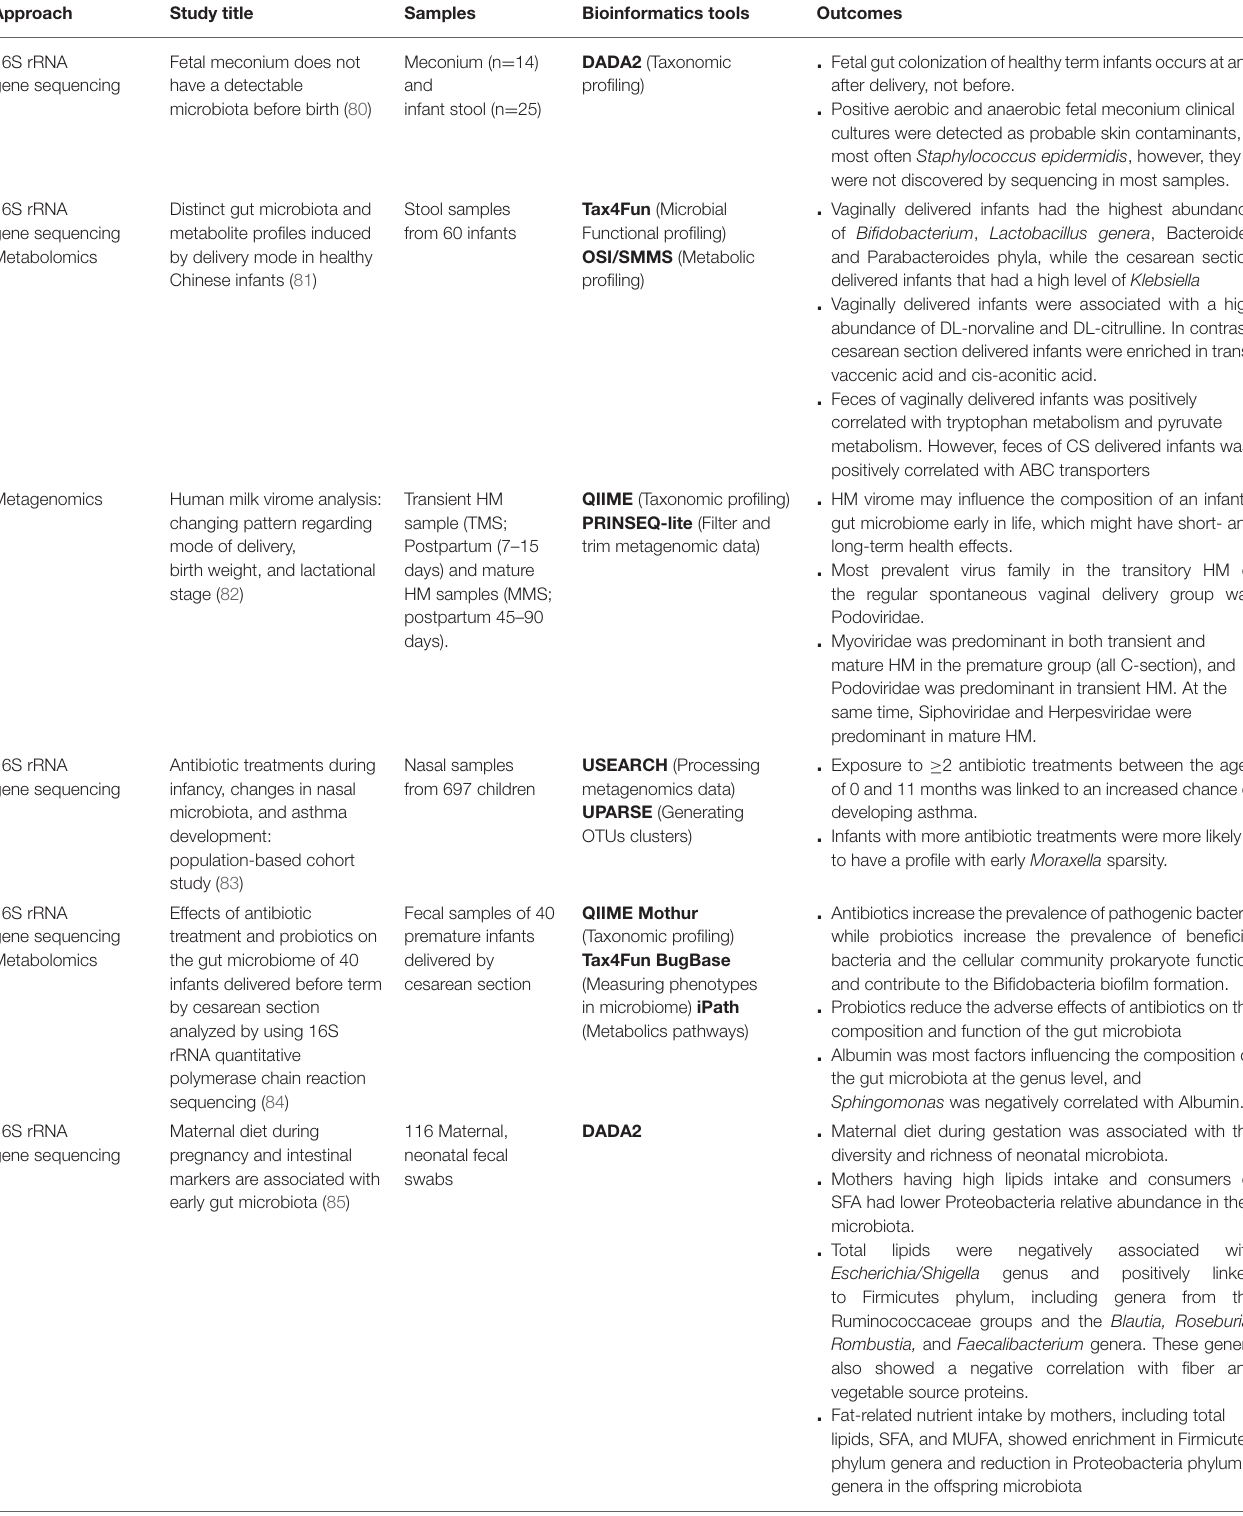
TABLE 2 | Metaomics technologies in neonatal microbiome studies